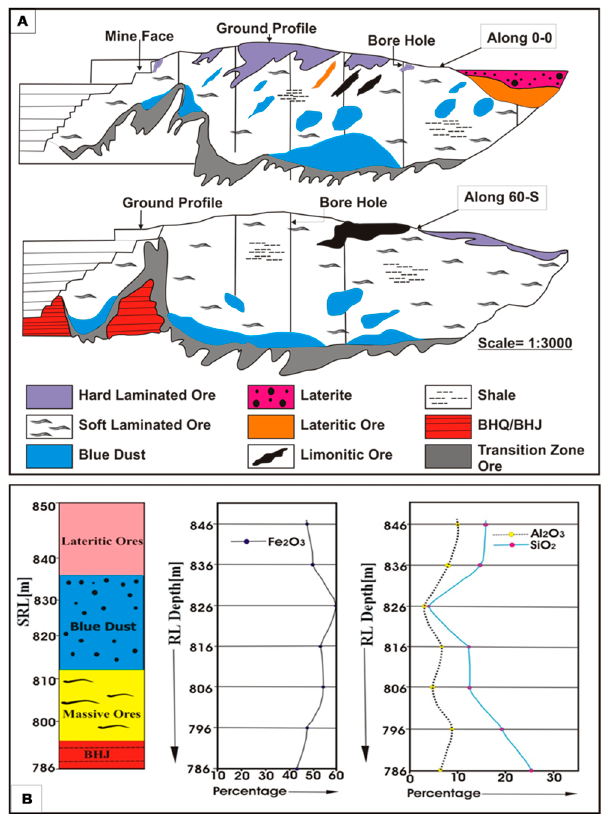
Figure 15. ( A ) Geological cross section along bore holes at KMIOD showing variable grades of iron ores imparting strong controls of various structural elements for the genesis of the iron ores; and ( B ) detailed drill-hole core log of iron ore deposit showing variation of Fe 2 O 3 , SiO 2 and Al 2 O 3 at depth and their variability between different types of iron ores.